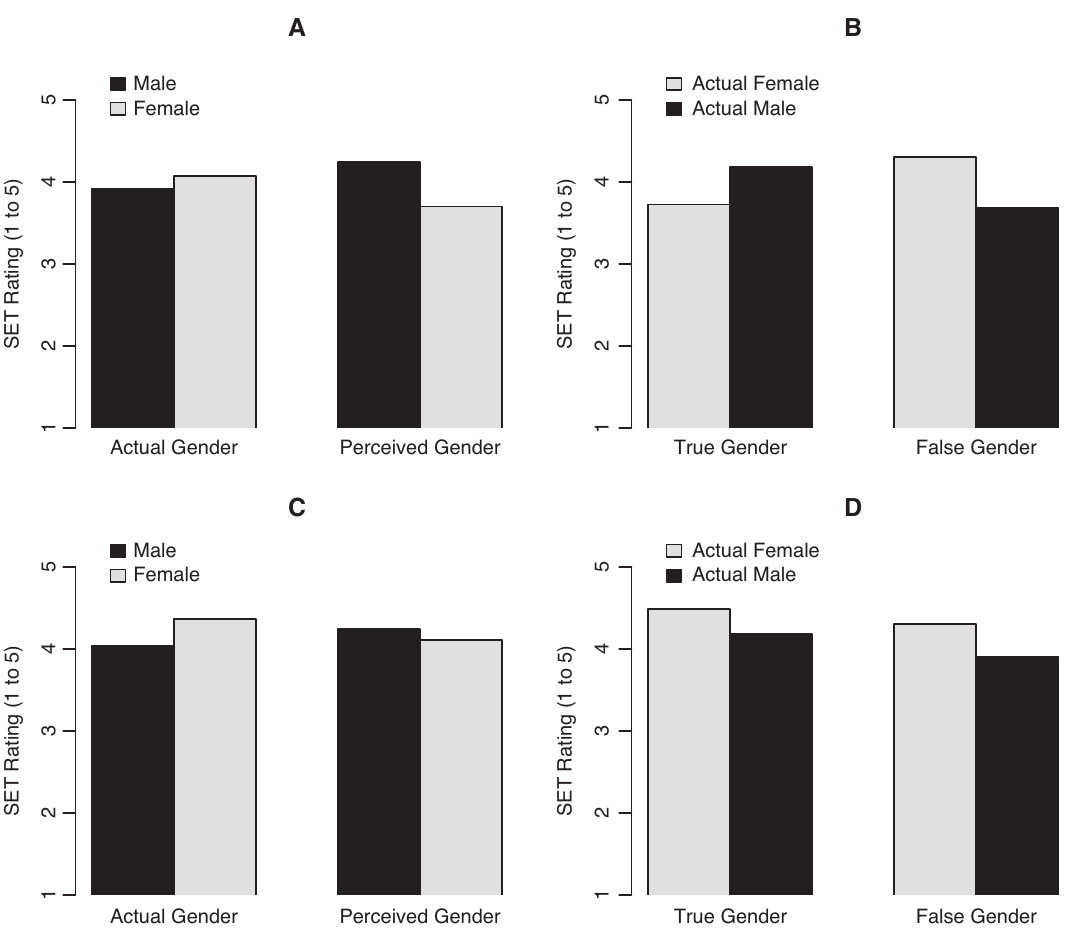
Figure 2. SET ratings for 12-item averages. Panel A shows the SET ratings for the actual male vs. female instructor and for the perceived male vs. female instructor for all data. Panel B shows the SET ratings by the four experimental conditions for all data. The instructor perceived as male received higher ratings that the instructor perceived as female. Panel C shows the SET ratings for the actual male vs. female instructor and for the perceived vs. female instructor when the three outliers are removed. Panel D shows the SET ratings by the four experimental conditions when the three outliers are removed. The actual female instructor received higher ratings than the actual male instructor, regardless of their perceived